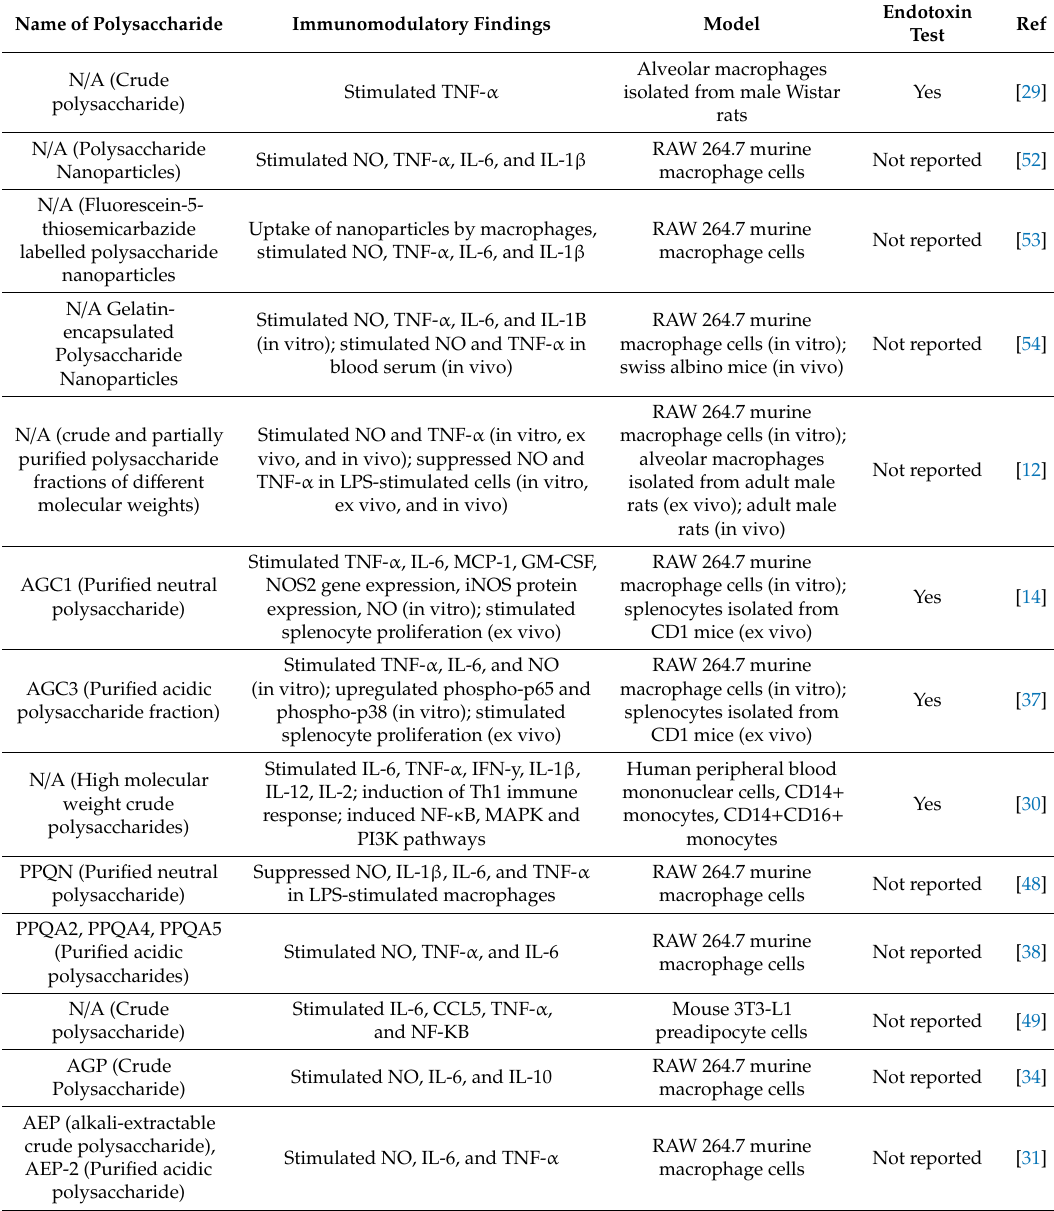
Table 2. Immunomodulatory activities of NAG crude and purified polysaccharides. Name of